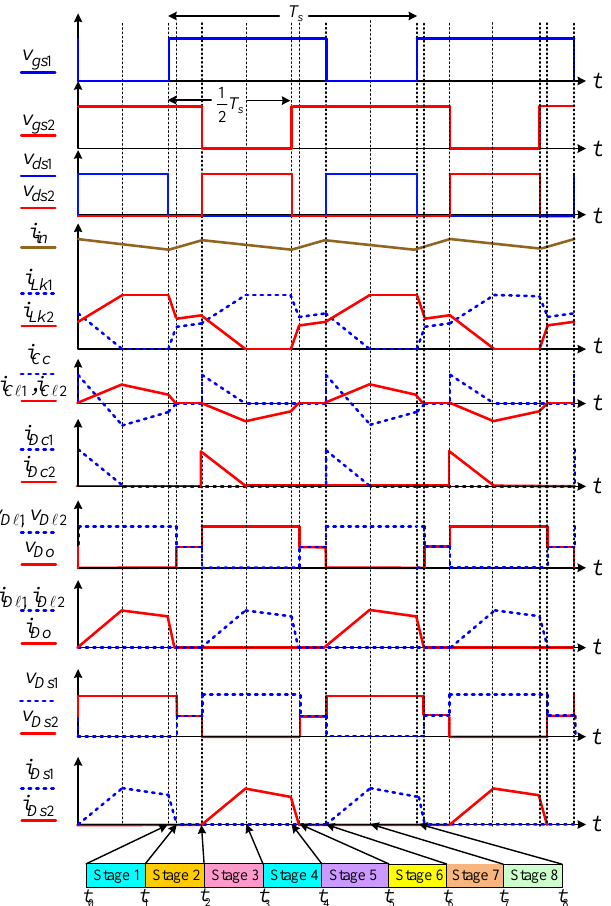
Figure 3. Theoretical waveforms of the proposed converter.